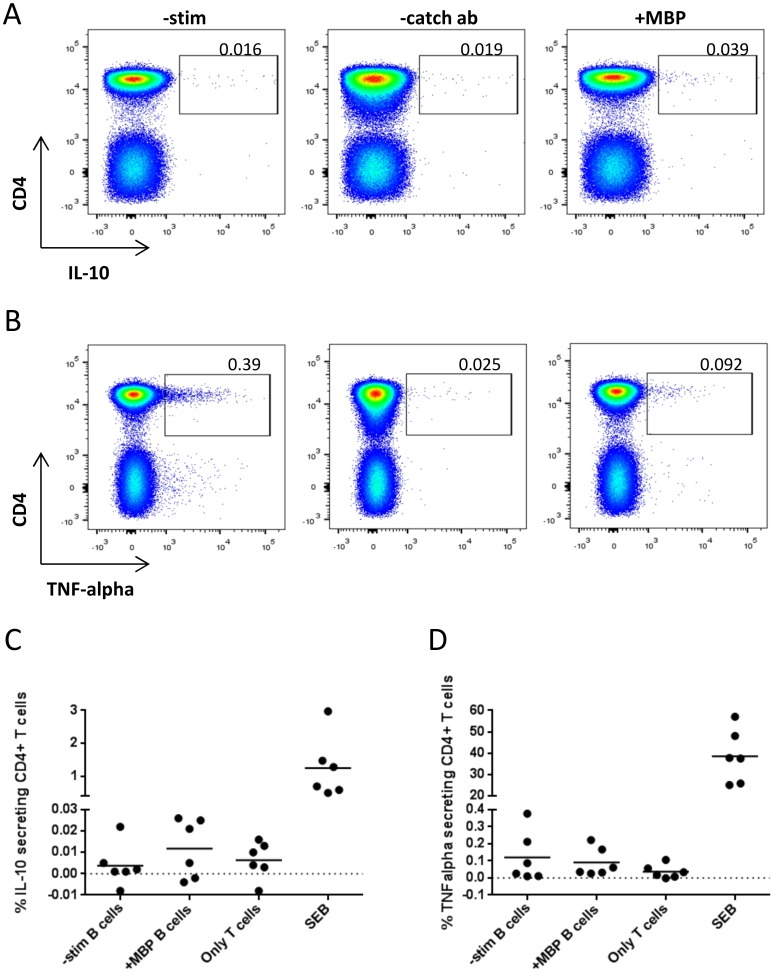
IL-10 and TNF-alpha secretion by MBP specific CD4+ T cells in co-cultures of T cells and B cells.500,000 CD3+ T cells were cultured with 100,000 CD19+ B cells ±30 µg/ml MBP for 18 h and the resulting IL-10 and TNF-alpha production in CD4+ T cells were measured. Shown is representative dot plots of (A) IL-10 and (B) TNF-alpha production in CD4+ T cells and individual values of the proportion of CD4+ T cells producing (C) IL-10 or (D) TNF-alpha (N = 6). Cultures stimulated by staphylococcal enterotoxin B (SEB) were used as positive controls and cultures containing only T cells were used as negative controls. Samples containing only detection antibodies (-catch ab) were included to correct background staining of the assay and these values were subtracted from all other samples.